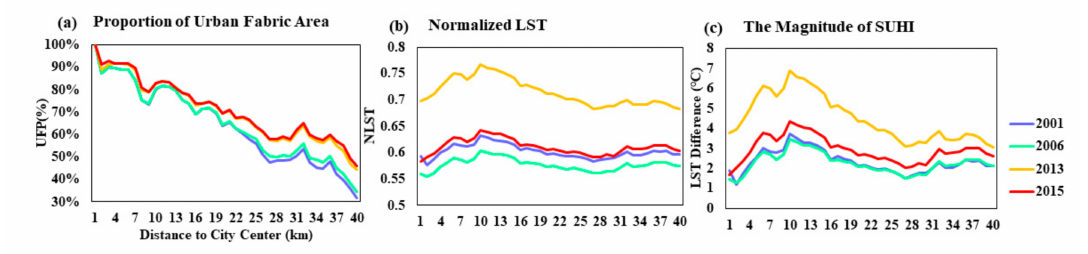
Figure 5. Urban–rural gradient: ( a ) proportion of urban fabric area, ( b ) normalized LST, and ( c ) magnitude of SUHI.